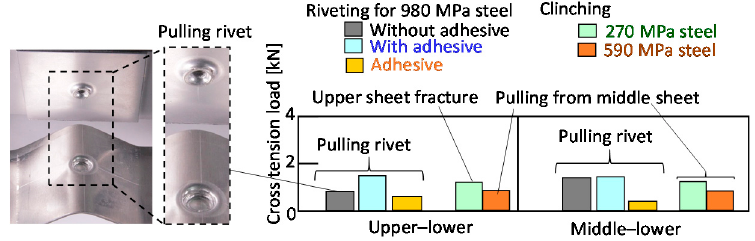
Figure 32. Cross-tension loads of riveted and clinched joints for the lower aluminium alloy sheet.